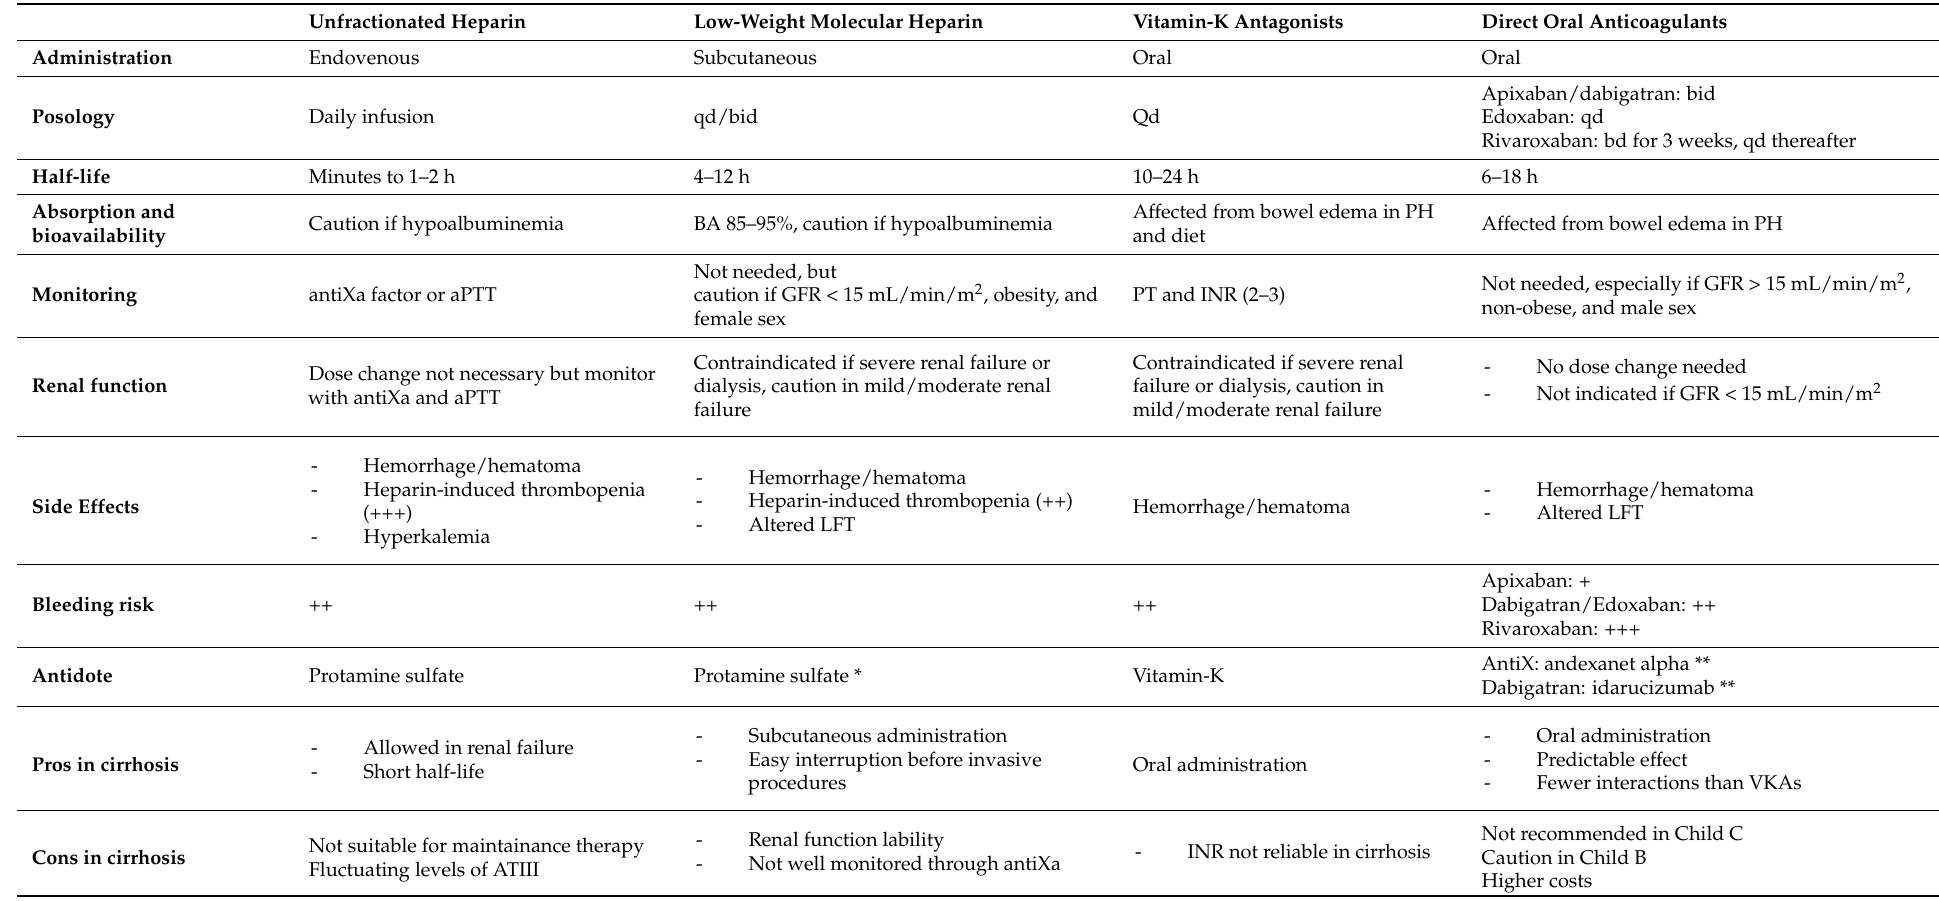
Table 3. Characteristics of the different anticoagulation therapies for the treatment of portal vein